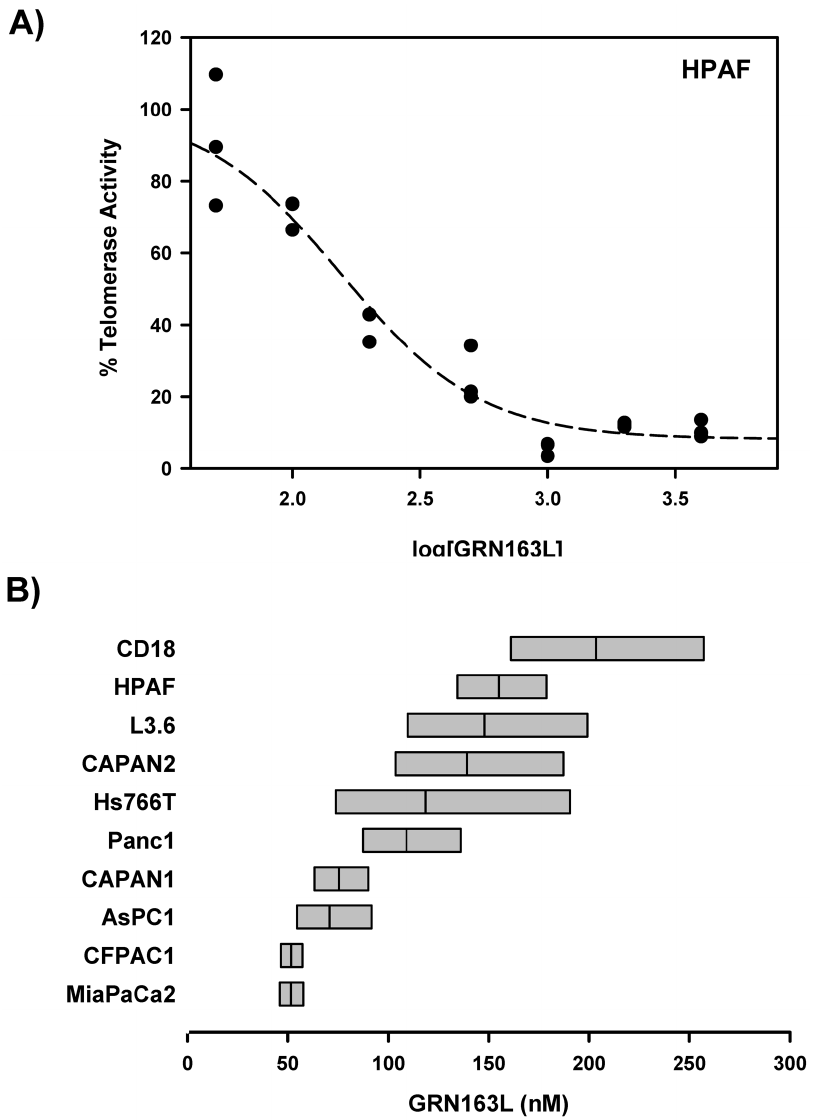
Figure 2. Short-term responses of pancreatic cancer cell lines to GRN163L. A) Dose-Response curve of telomerase inhibition by GRN163L. HPAF cells were treated in triplicate with increasing concentrations of GRN163L (50 nM to 4 m M). Twenty-four hours later, telomerase activity was measured using the TRAP assay. Samples treated with no drug were set to 100%. B) IC 50 of each line for the inhibition of telomerase by GRN163L. Dose-response curves were performed as in panel A. Non-linear curve fitting allowed calculation of an IC 50 for each line. Results are expressed as the IC 50 (middle bar) and its 95% interval of confidence (flanking bars).